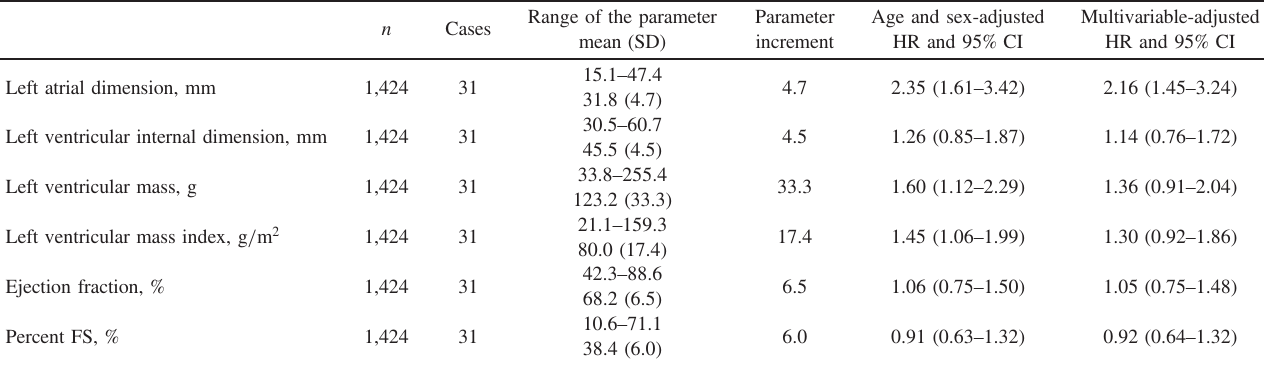
Range of the parameter n Cases mean